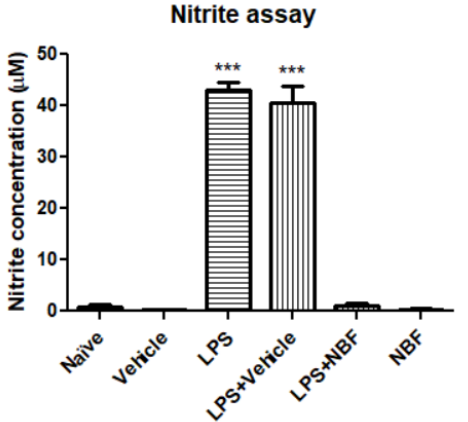
Figure 5. NBF downregulates the secretion of nitrite in RAW264.7 macrophages following LPS stimulation. RAW 264.7 macrophages were exposed to 20 ng/mL LPS and simultaneously with the NBF, 20 µ g/mL. Nitrite levels were measured using standard calibration curve with sodium nitrite and are presented as the mean ± SD. Four replicates in each group ( n = 4). ANOVA followed by Bonferroni’s post hoc test was performed. *** p < 0.001 compared to all other